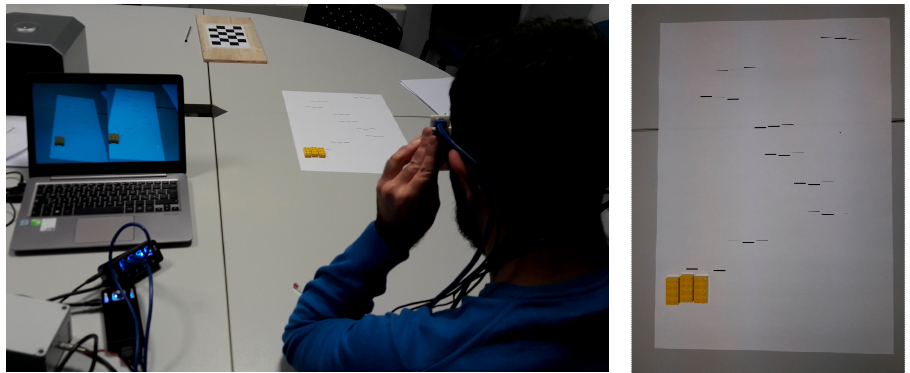
Figure 6. On the left: experimental setup for depth estimation tests. On the right: paper sheet with marked segments. The segments were used for placing the triplets of bricks at different absolute depths from the observer and with random patterns of relative depths among them.